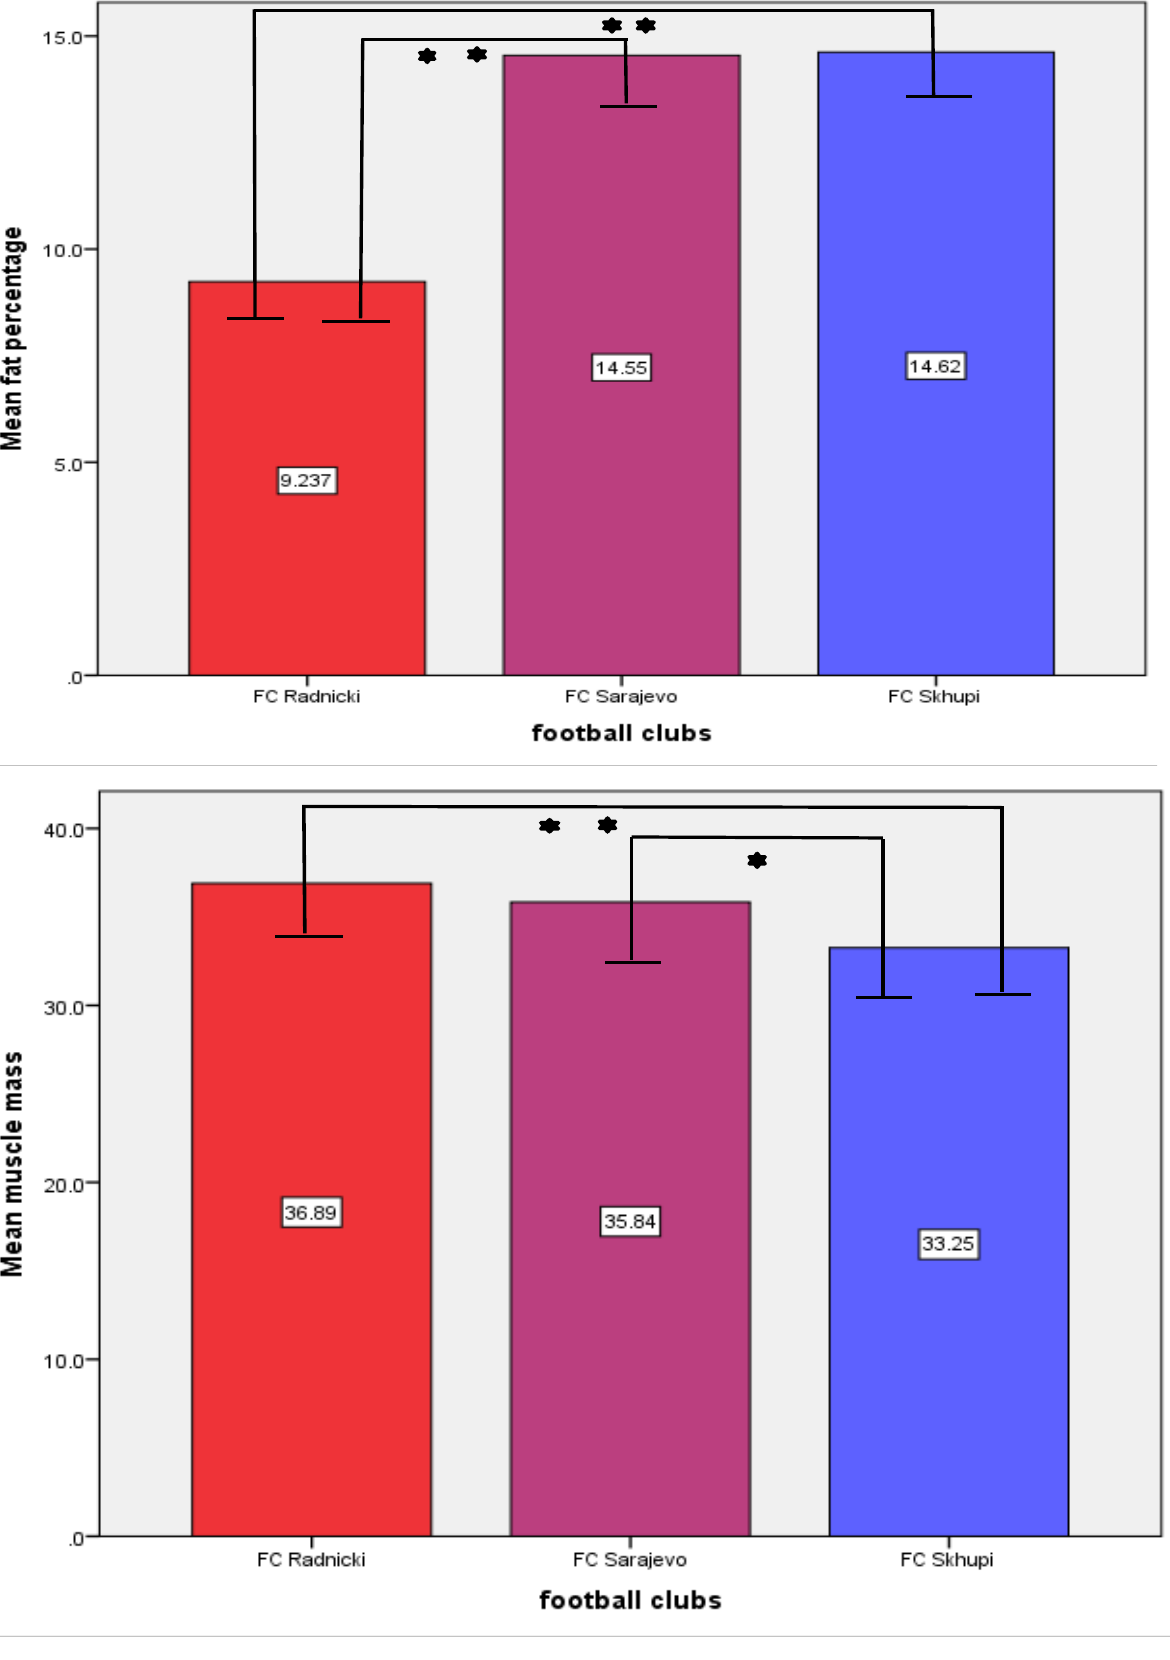
Figure 1. Statistically significant differences between young football players of football clubs in two variables - fat percentage and muscle mass (*p<.05; **